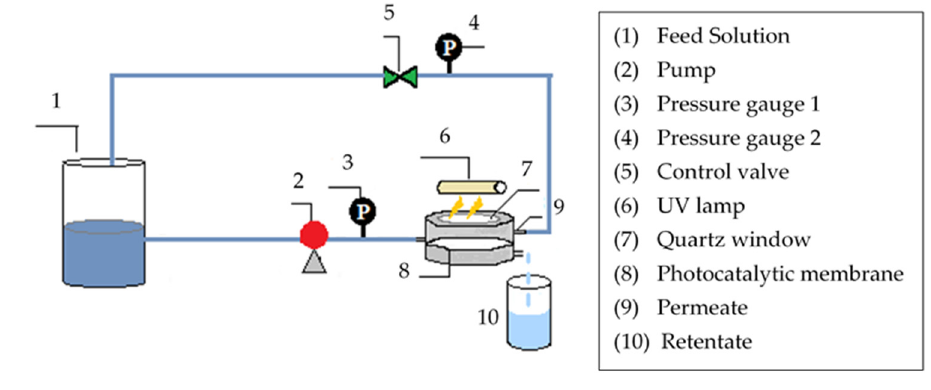
Figure 12. Schematic of the crossflow system.